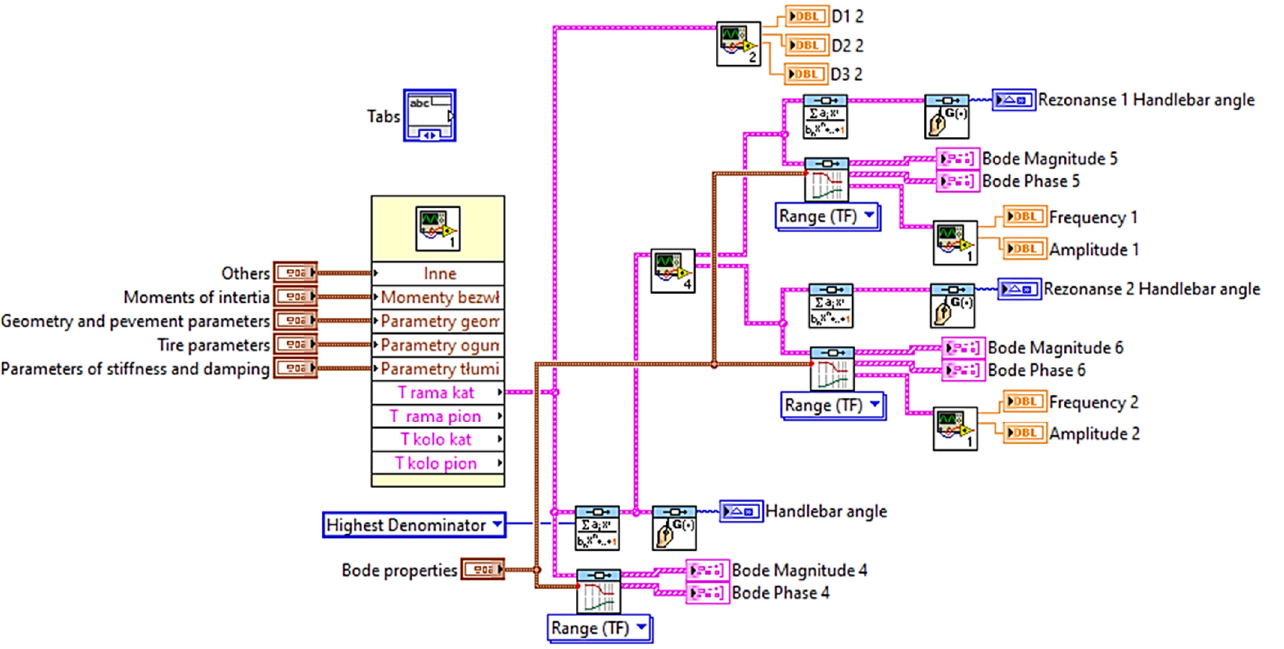
Figure 6. View of a window with a code fragment of the steering frequency analysis program. With the program thus developed, the Bode plots summarized below were obtained along with the significant values read from the plots.